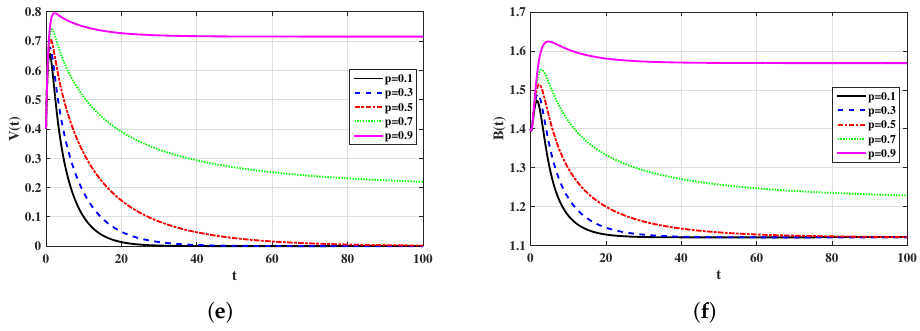
Figure 2. The simulation of trajectories of the system in Equations (19)–(23): ( a ) uninfected target cells type-1; ( b ) uninfected target cells type-2; ( c ) latently infected target cells type-1; ( d ) latently infected target cells type-2; ( e ) actively infected target cells type-1; ( f ) actively infected target cells type-2; ( g ) free virus particles; and ( h ) B